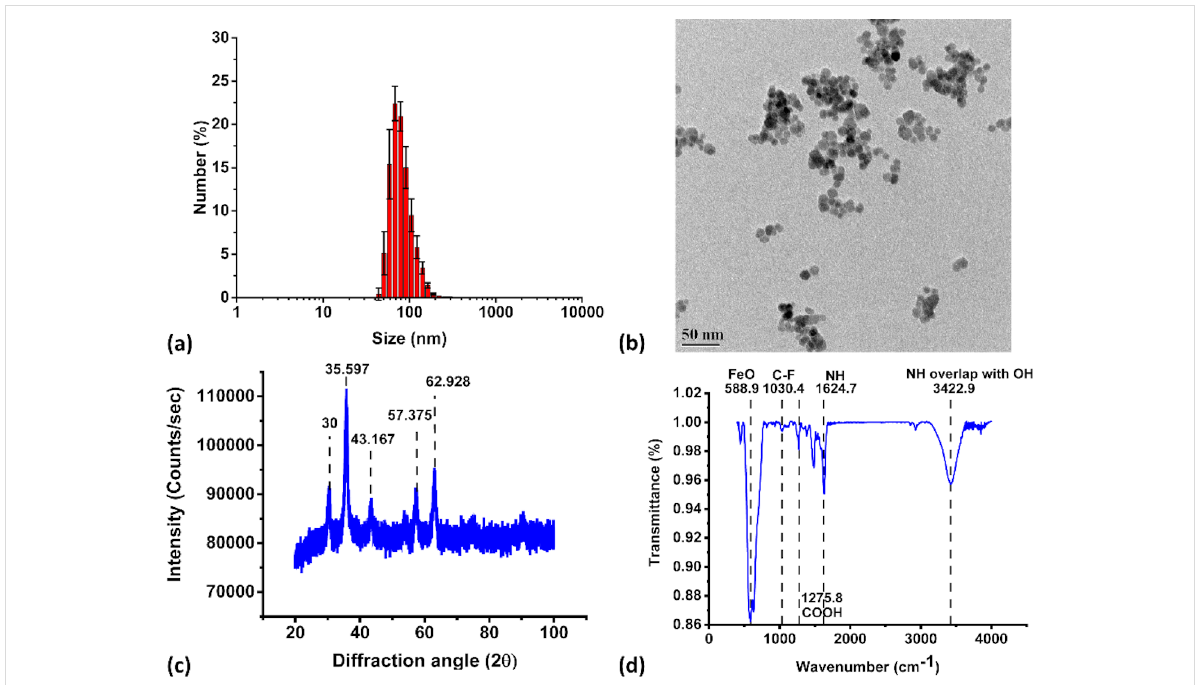
Figure 3: Characterization of NOR@IONP pH5 nanoparticles. (a) Dynamic light scattering plot of number (%) v/s size (nm) of the nanoparticles in solu- tion at the end of synthesis ( n = 3). (b) Transmission electron microscopy image with a 50 nm scale bar. (c) X-ray diffraction plot indicating the Bragg’s